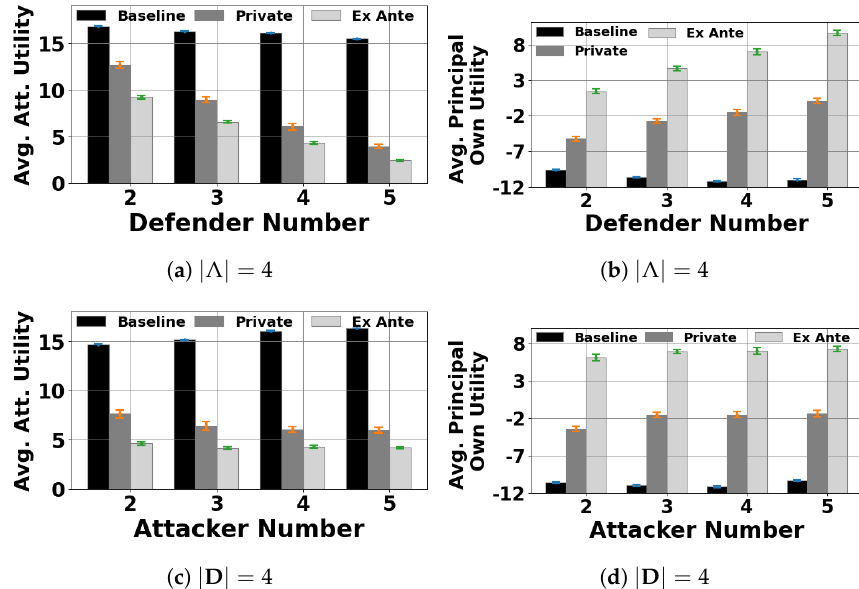
Figure A3. The principal optimizes her own utility when | T | = 12 and the defenders’ cost range C d ( t ) ∈ [ 0,10 ]